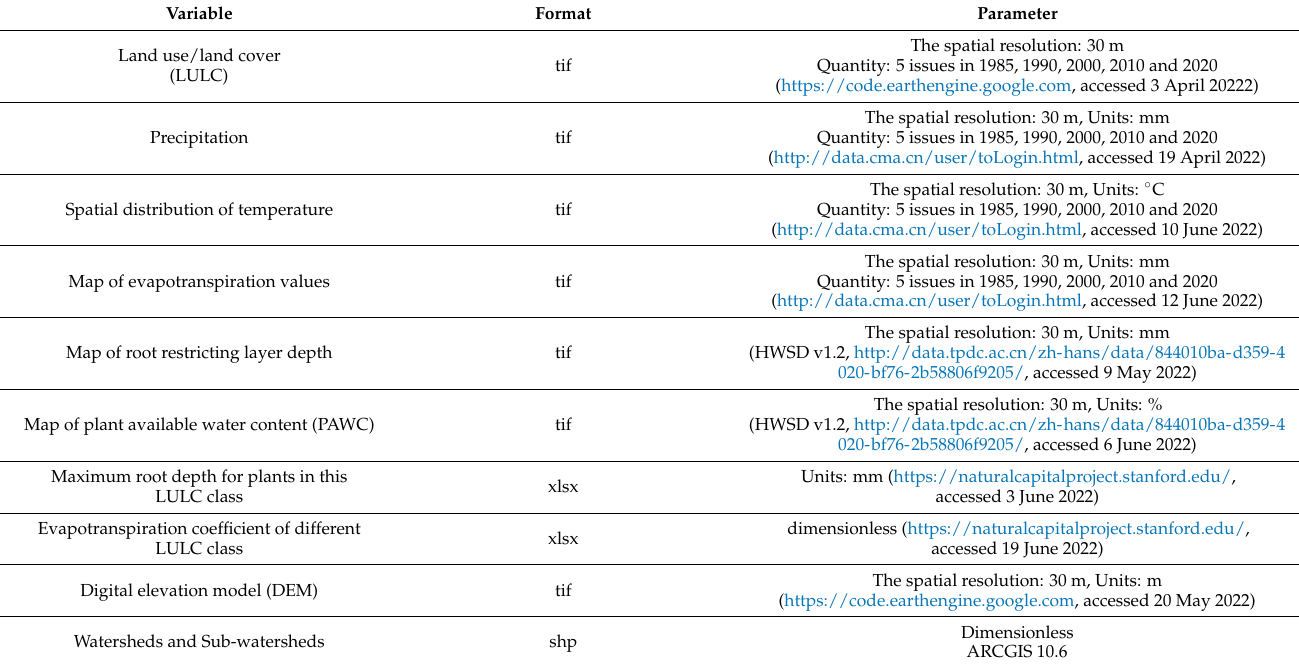
Figure 3. Flowchart of water yield performed in this study. Table 2. InVest model data structure and data information used in this